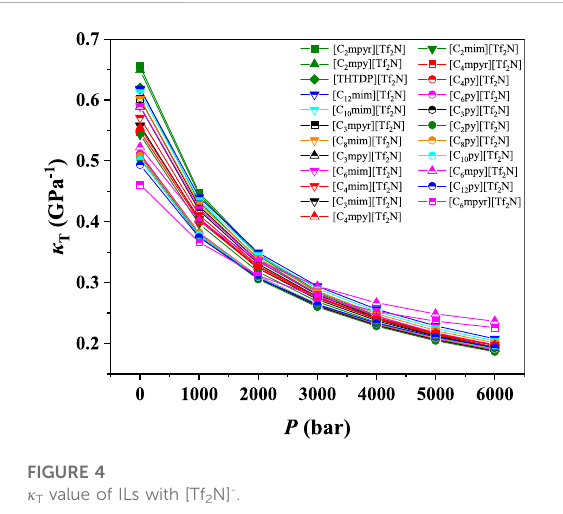
FIGURE 4 κ T value of ILs with [Tf 2 N] -